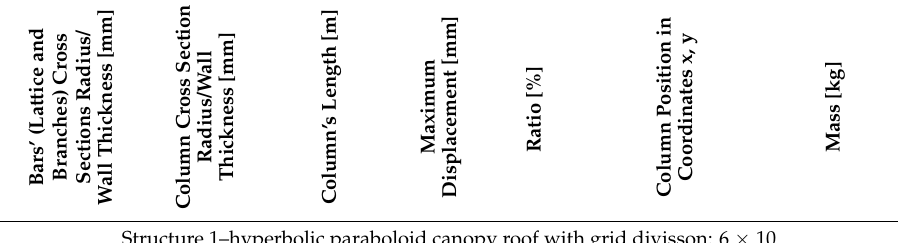
Table 1. Results of the single objective structural optimization achieved by means of Grasshopper for three